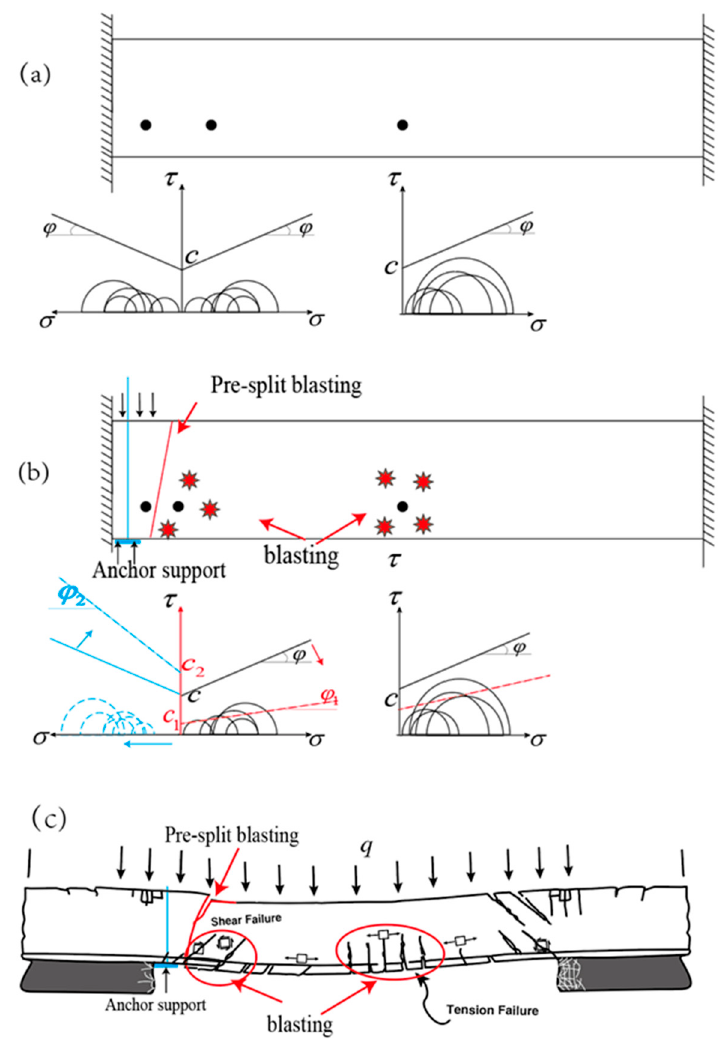
Figure 3. Mechanical analysis of the treatment of thick and hard roof of non-pillar mining ( a ) Mechanics analysis of roof without any measures ( b ) Mechanics analysis of roof after taking blasting and supporting measures ( c ) Schematic diagram of roof cracks and collapse after taking blasting and supporting measures.